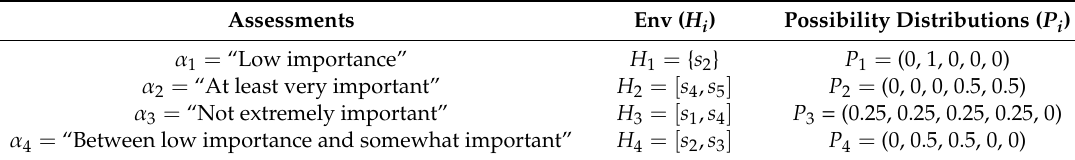
Table 1. Linguistic assessments, HFLTSs and possibility distributions of Example